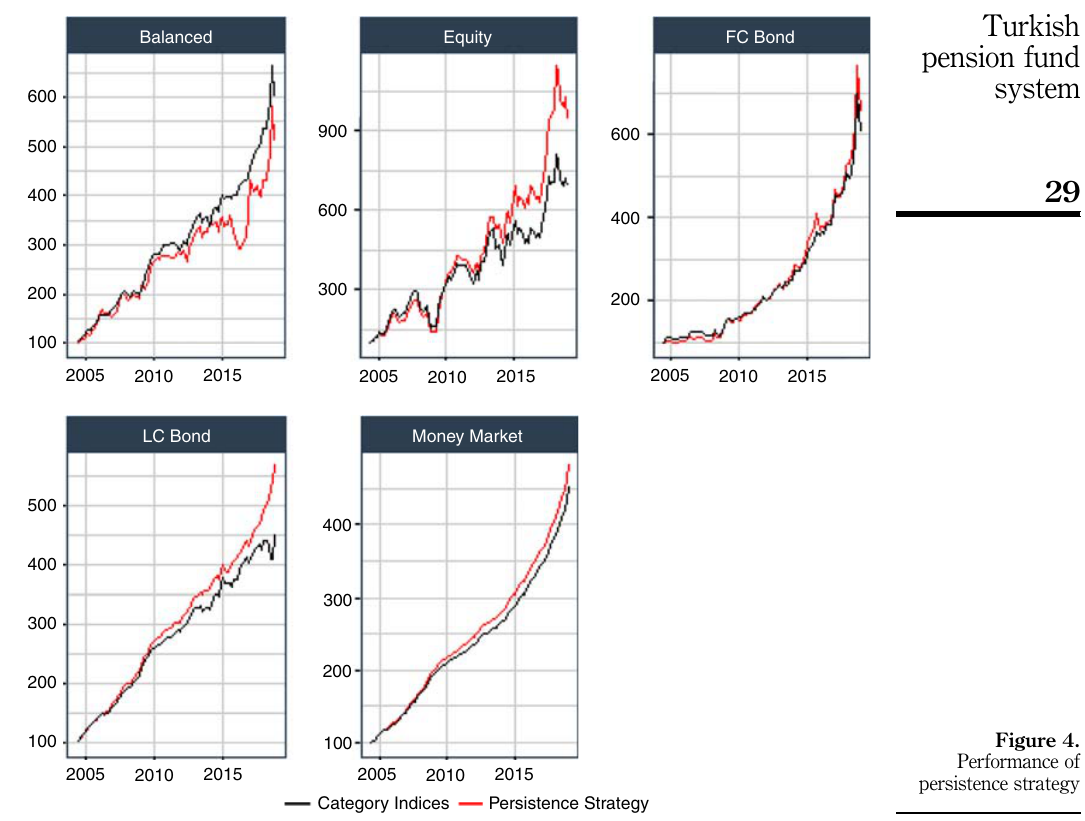
Figure 4. Performance of persistence